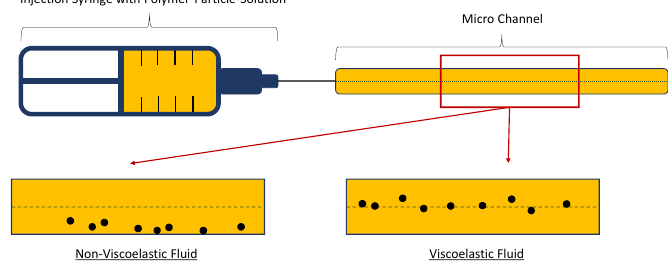
Figure 10. Microfluidic setup for measuring relaxation time of viscoelastic polymer solutions (modified after Del Giudice et al. [81]).